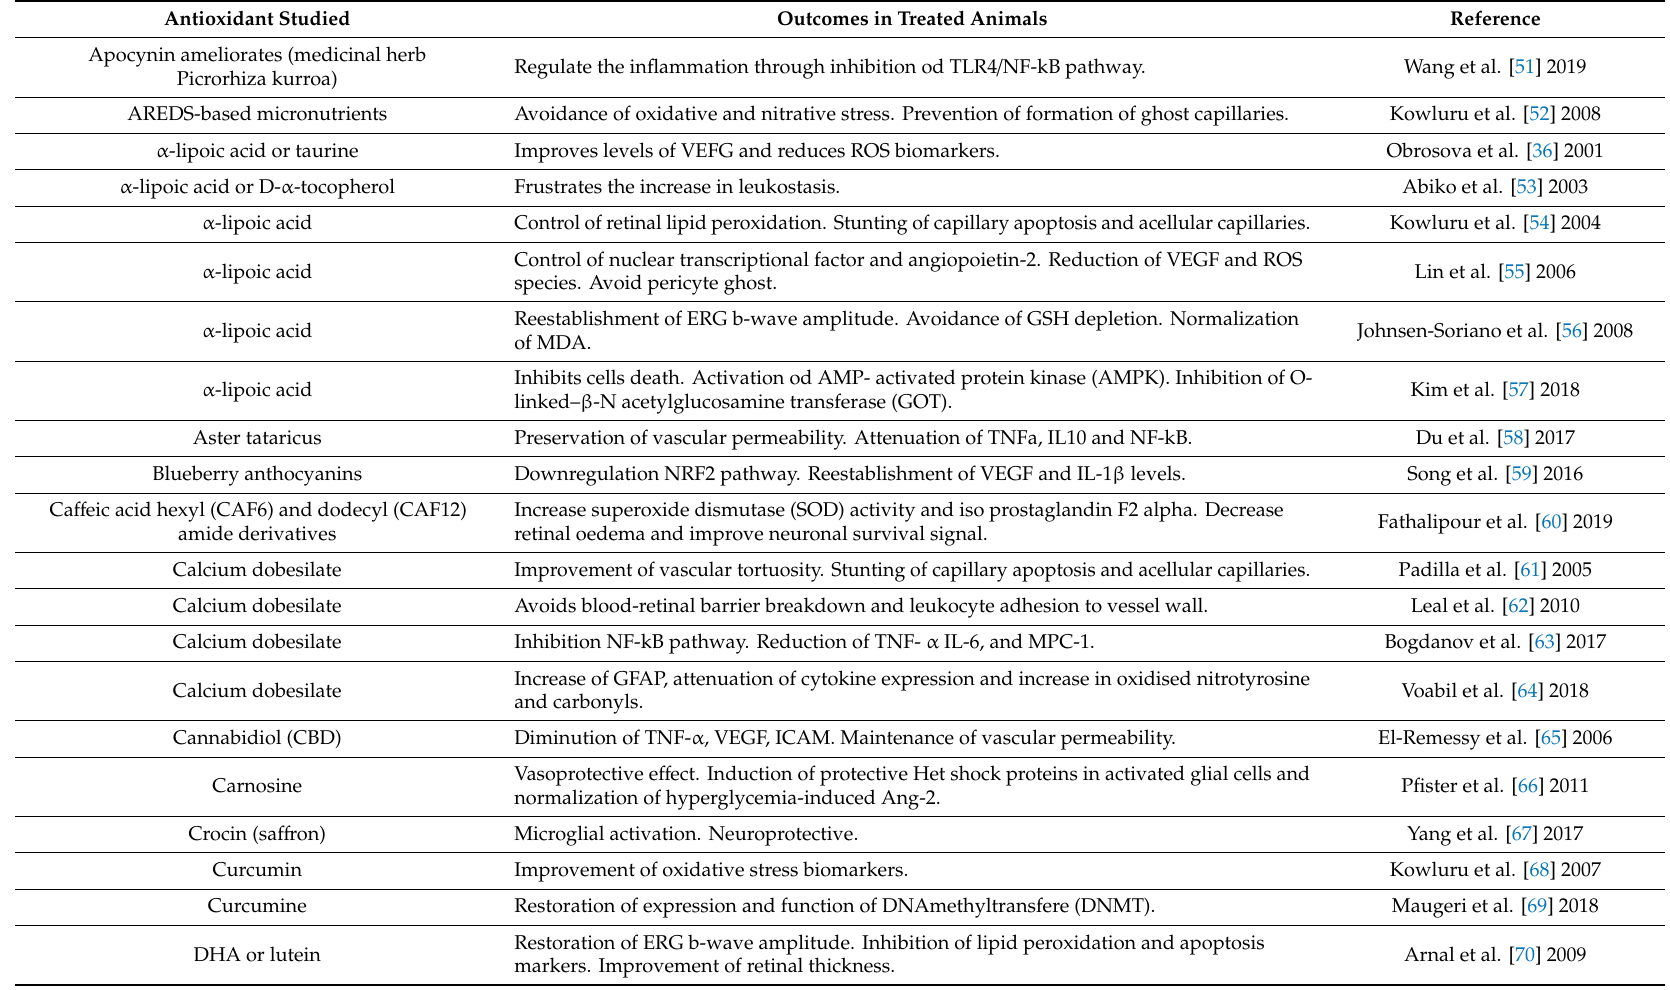
Table 2. Results of antioxidant supplementation in animal